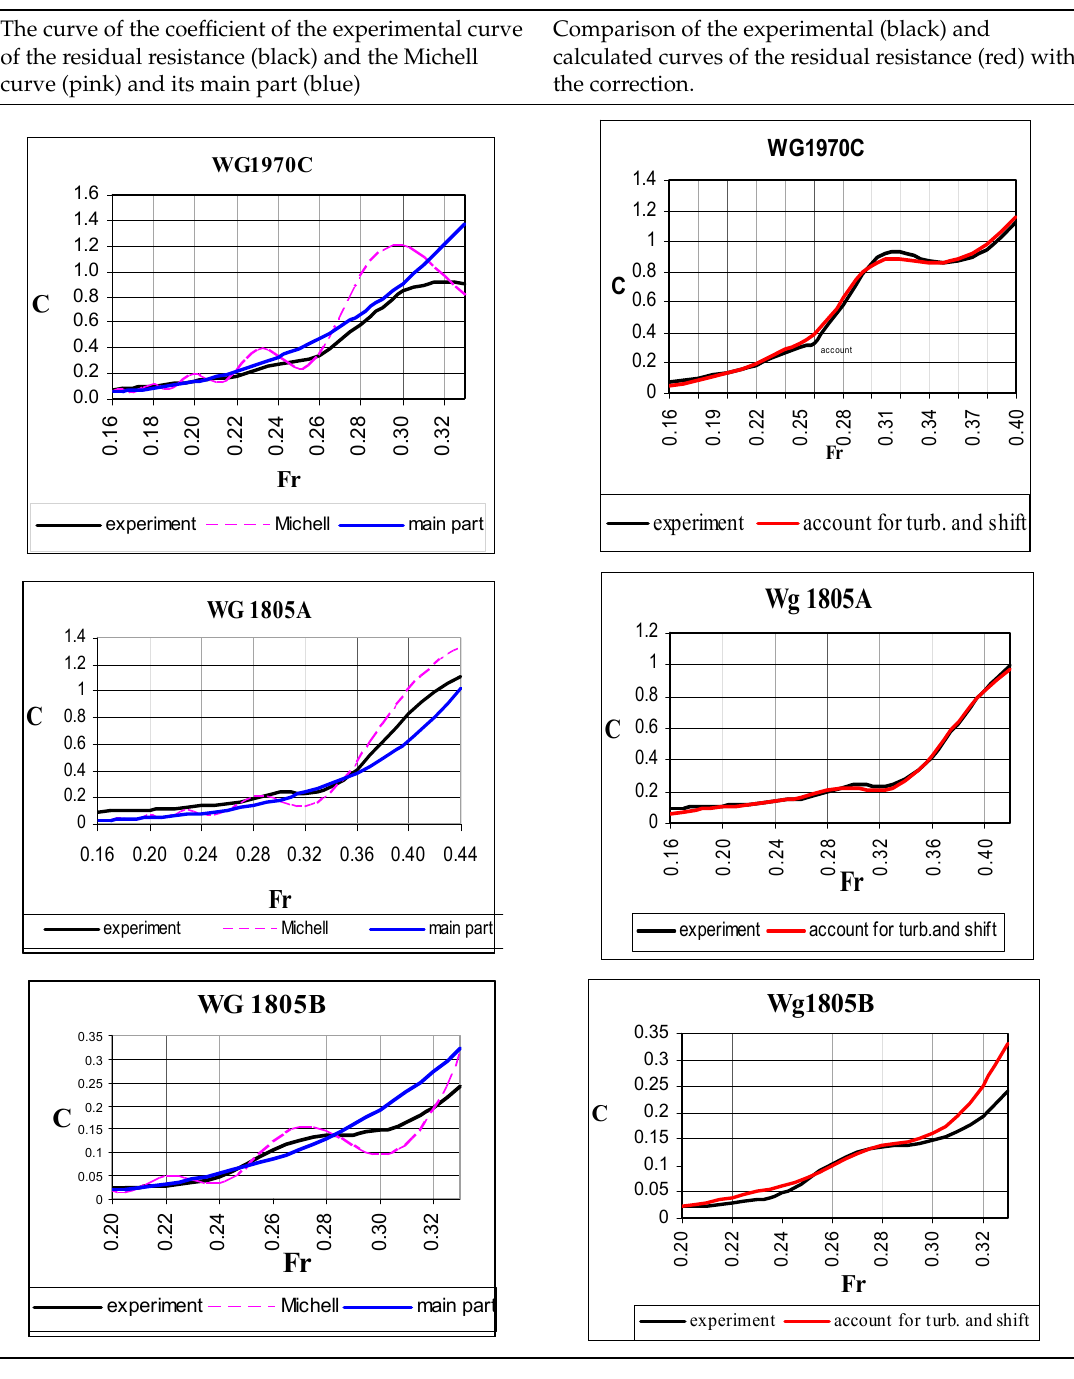
Table 7. Cont. Comparison of the experimental (black) and calculated curves of the residual resistance (red) with the correction. J. Mar. Sci. Eng. 2020 , 8 , x FOR PEER